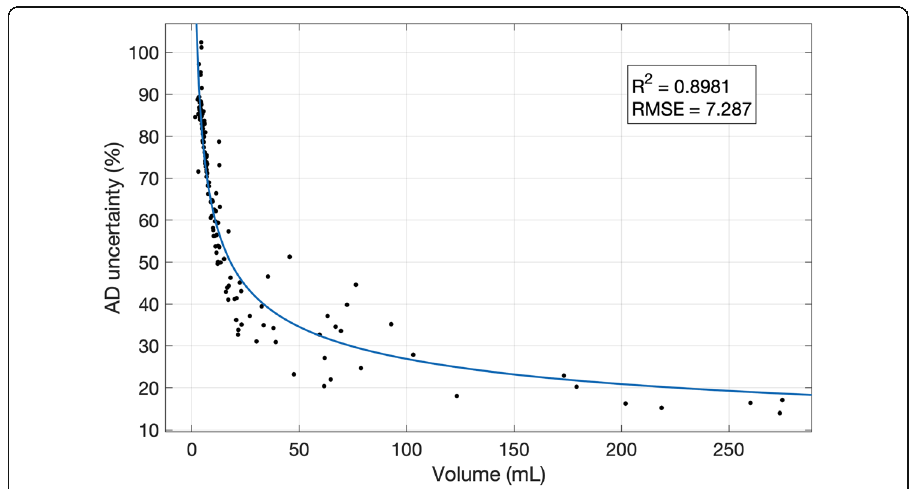
Fig. 4 Absorbed dose uncertainty (%) against volume (mL). Points were fitted with a power function. R2 and RMSE are reported in the